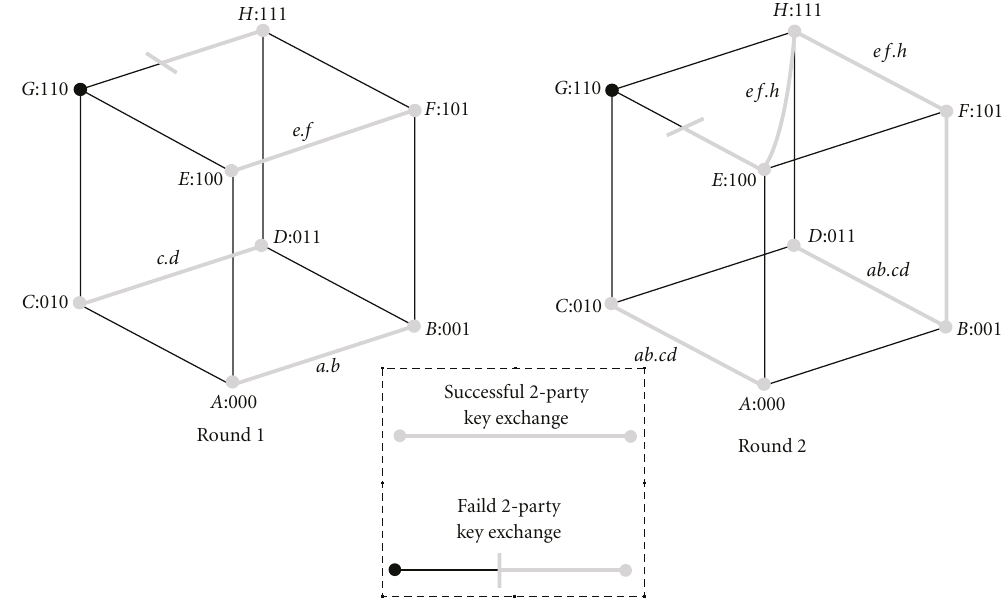
Figure 4: Asokan’s 3-d cube round 1, 2.